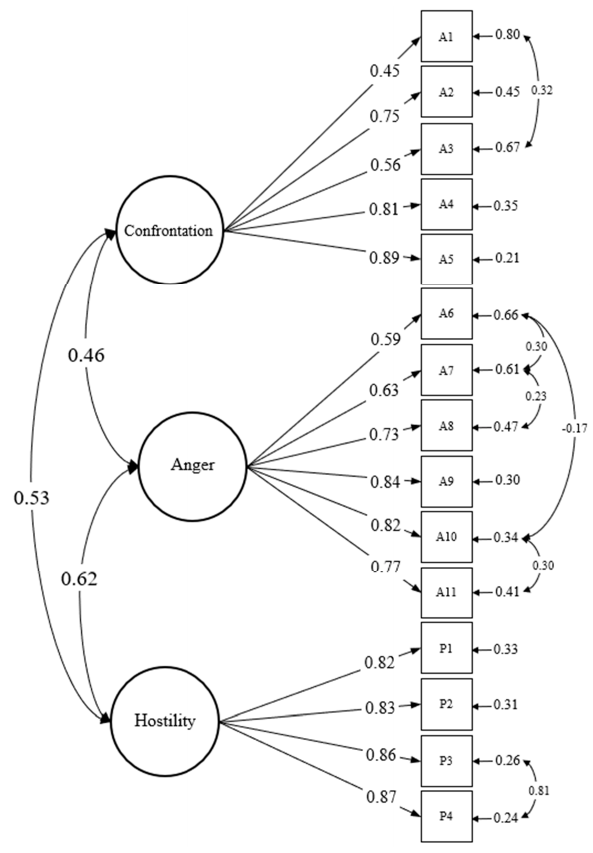
Figure 1. Full Measurement Model for Aggression Latent Factors. Note. Circles represent latent factors. Squares represent indicators; A1–A11 refer to scale items for confrontational and anger aggression. P1–P4 are parceled items of hostility. Values on the longer arrows signify path coefficients. Values for the shorter arrows represent residual variances. Double-headed curved arrows represent correlations between latent factors or residual variances. All coefficients shown are standardized and obtained statistical significance at the 0.05 level. Table 3. Model Fit Indices for Measurement and Structural Models.